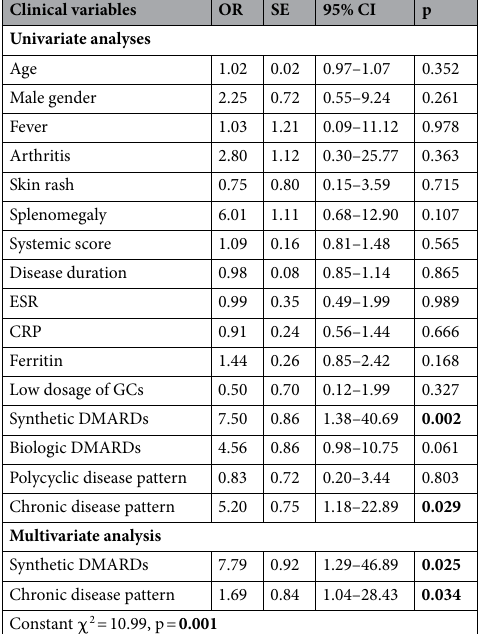
Table 1. Multivariate regression analysis of predictive factors on the likelihood of MRI-bone erosions in AOSD. MRI magnetic resonance imaging, AOSD adult onset Still’s disease, OR odds ratio, SE standard error, 95% CI 95% confidence interval, ESR erythrocyte sedimentation rate, CRP C-reactive protein, GCs glucocorticoids, DMARDs disease modifying anti-rheumatic drugs. Bolded values are statistically significant (p < 0.05).